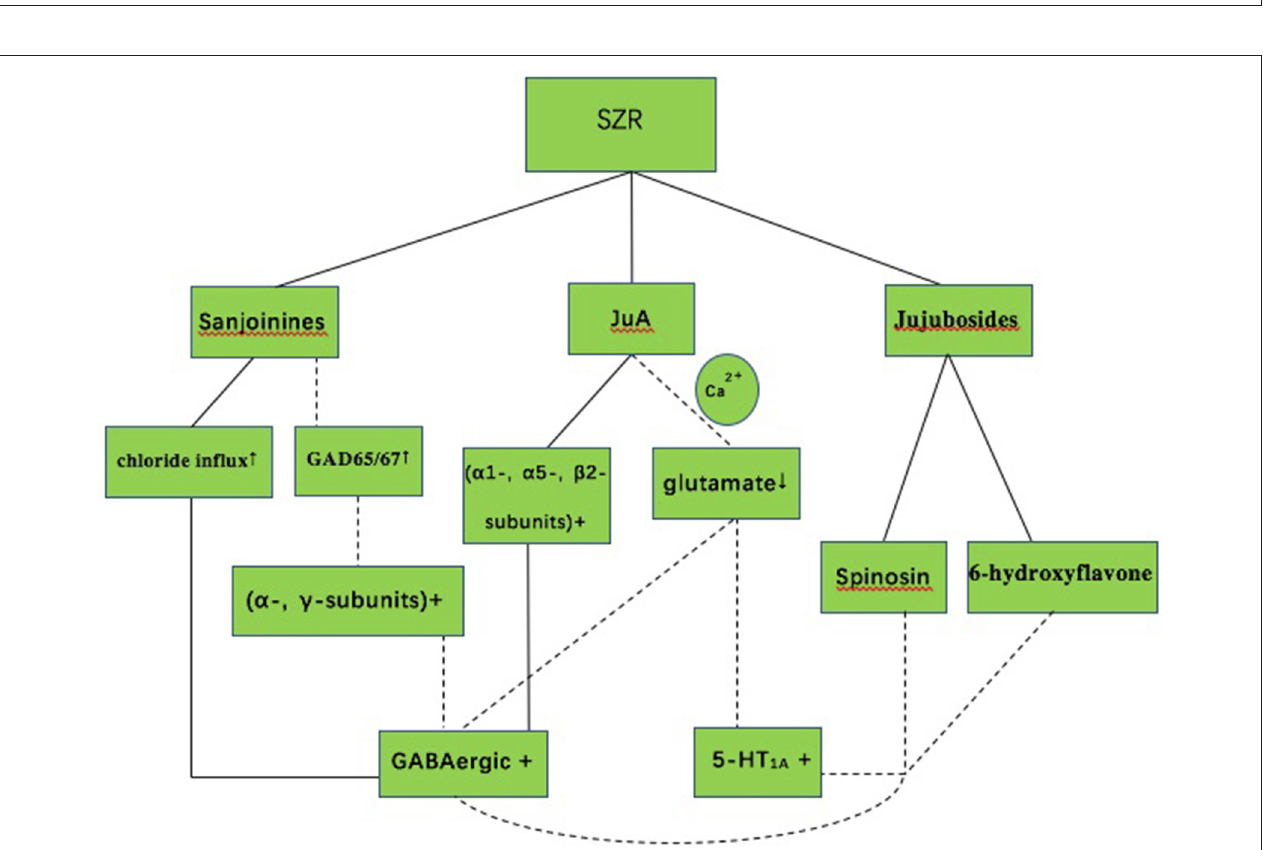
FIGURE 5 | The mechanism of sedative-hypnotic effect in SZR for insomnia. SZR, suanzaoren; GABA, gamma-aminobutyric acid; 5-HT 1A , 5-hydroxytryptamine (1A); JuA, Jujuboside A; Solid lines indicate established effects, whereas dashed lines represent putative mechanism.